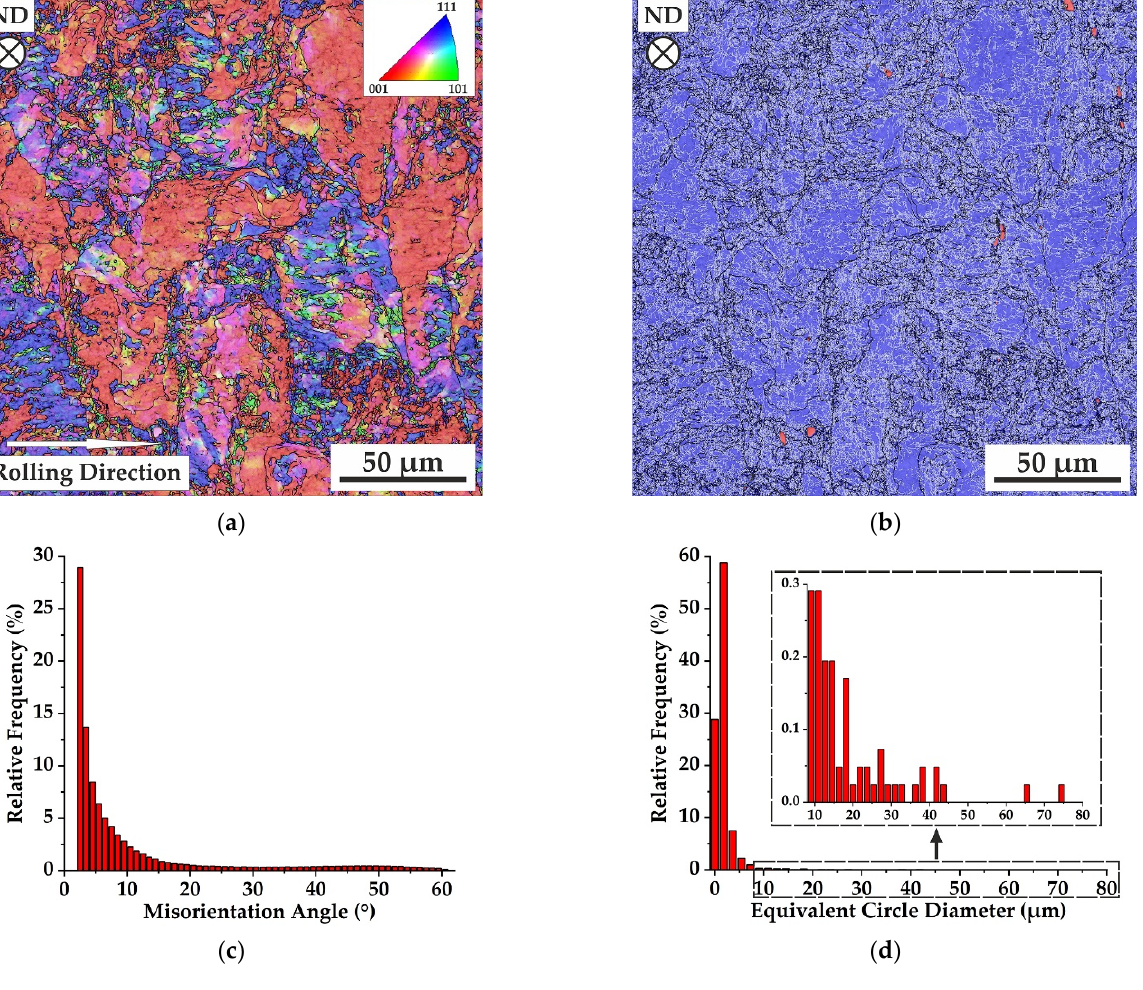
Figure 6. SEM EBSD images of steel microstructure after HTMT-3 in the section perpendicular to normal direction (ND). Orientation map ( a ), phase map, where austenite is in blue color, carbides is in red color with high-angle and low-angle boundaries are denoted by black and white lines, respectively ( b ), grain misorientation distribution ( c ), grain sizes distribution ( d ).